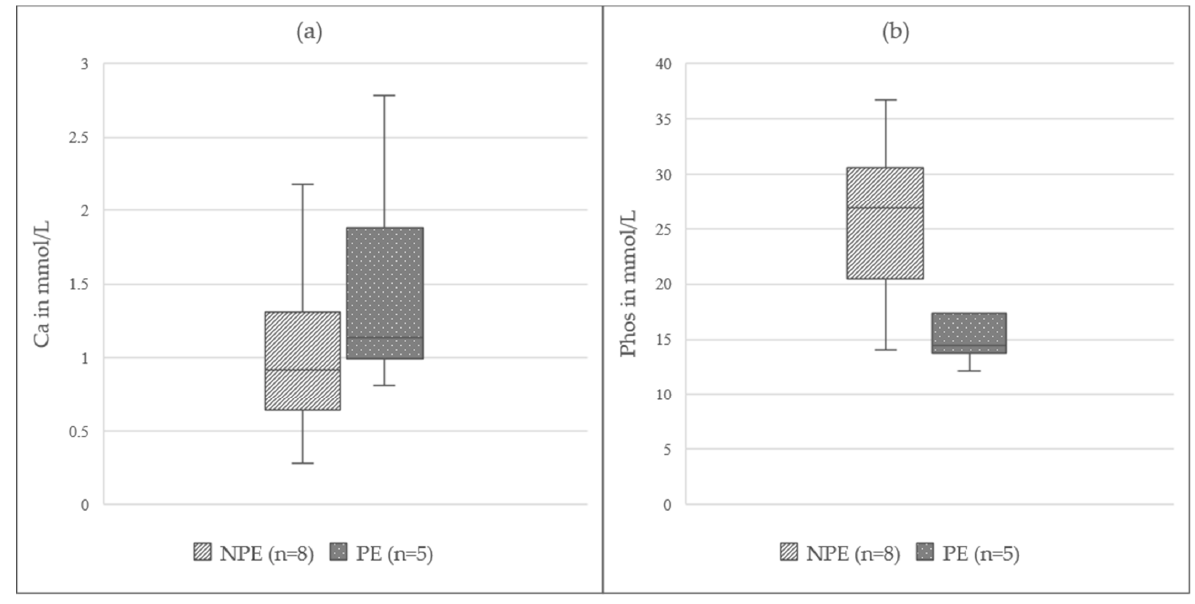
Figure 3. ( a ) Total calcium in ruminal fluid of non-pregnant ewes (NPE) and pregnant ewes (PE) under general anaesthesia for laparotomy ; Ca = total calcium; the boxplots represent the interquar- tile range and the respective maximum and minimum, together with the median. ( b ) Phosphate in